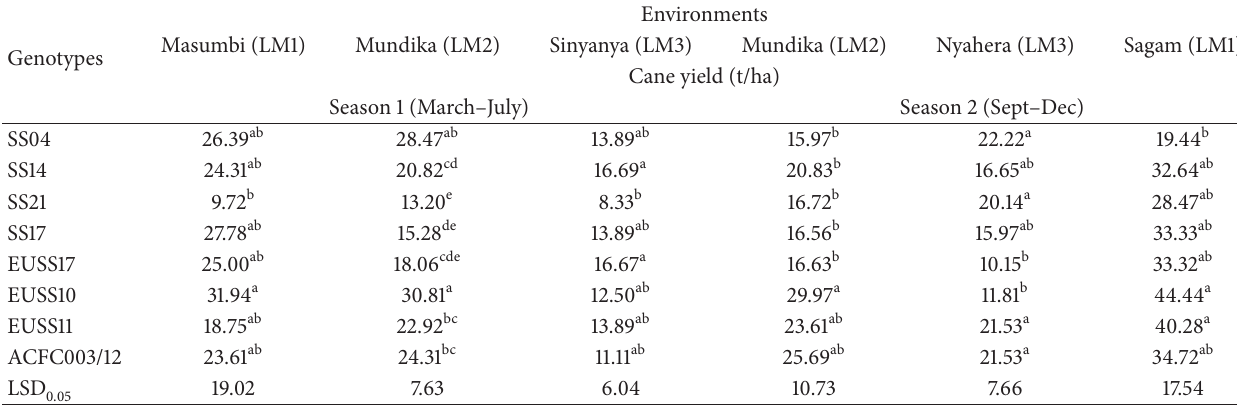
Means followed by the same letter do not differ at the same column at 5 % LSD.